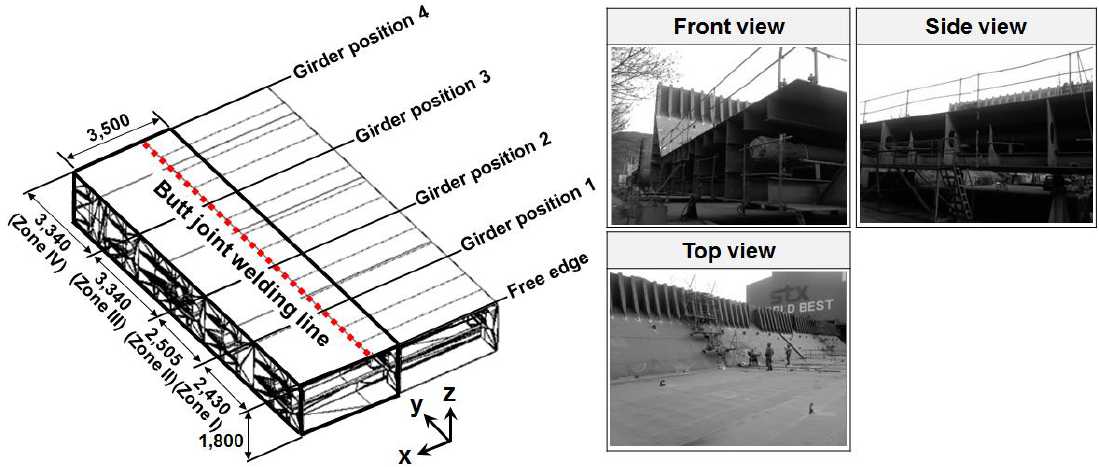
Figure 19. Panel block for simulation.